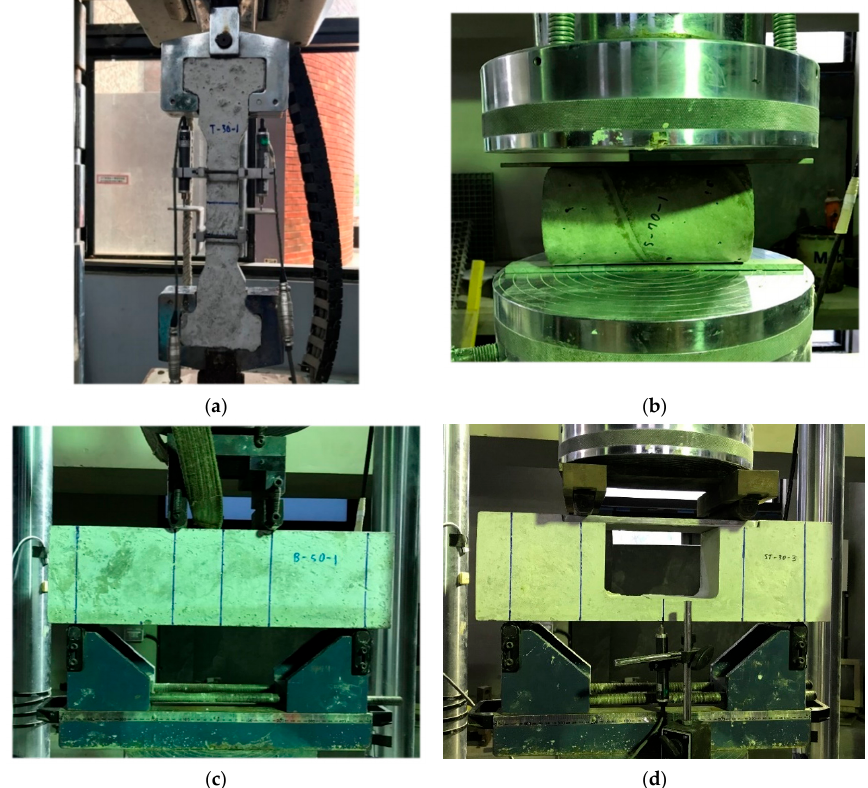
Figure 9. Test setup for different tests: ( a ) Direct tension test, ( b ) Splitting test, ( c ) Flexural test, and ( d ) Strut-and-tie beam test.